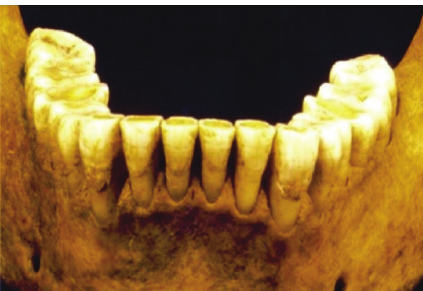
Figure 4: The helicoidal plane. The wear pattern produces an occlusal twist of the molar teeth. The buccal inclination on the first molars changes to a neutral inclination on the second molars that in turn changes to a lingual inclination on the third